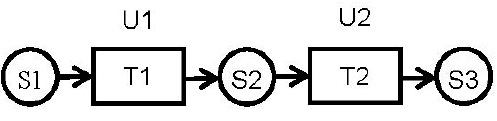
Figure 1. A simple state-task.